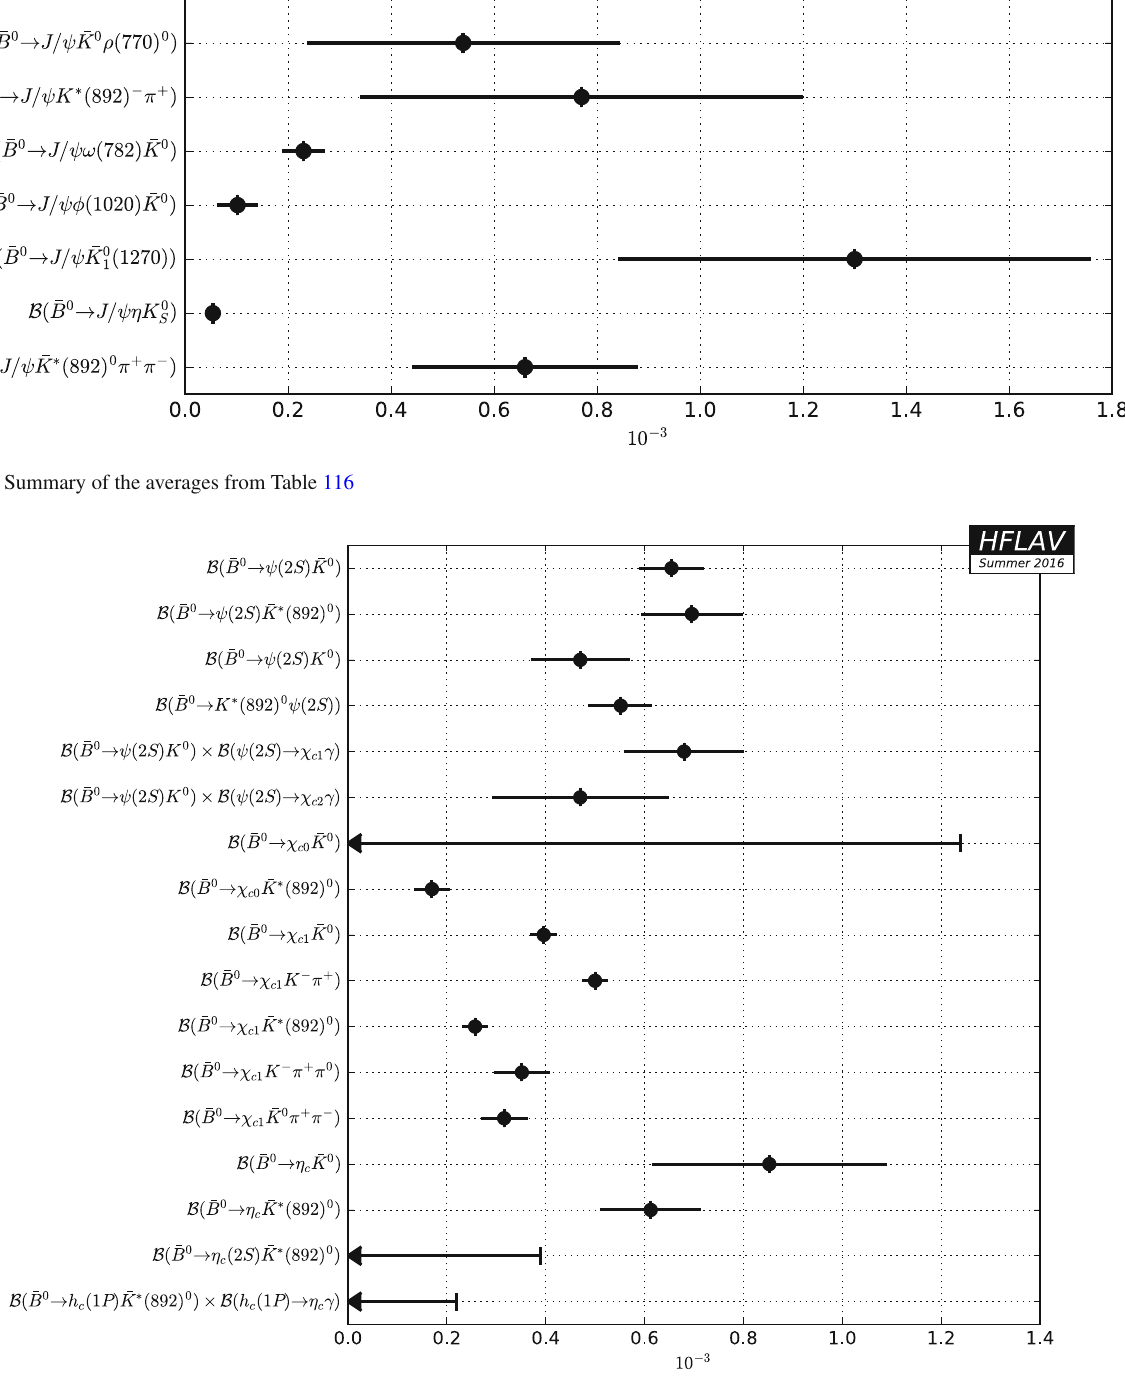
Fig. 91 Summary of the averages from Table